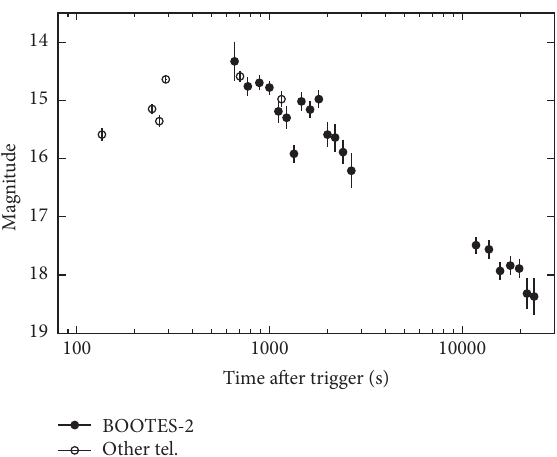
Figure 12: The optical light curve of GRB 130606A. 𝑖 󸀠 -band points were shifted 2.4 mag up to match with the 𝑧 󸀠 -band